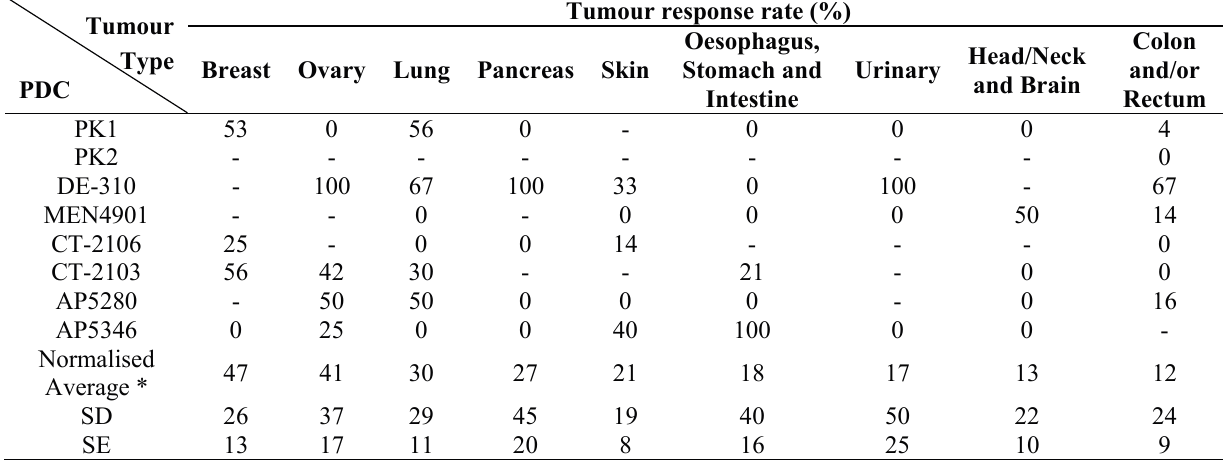
Table 4. Tumour response rates for PDCs (release mediated only by